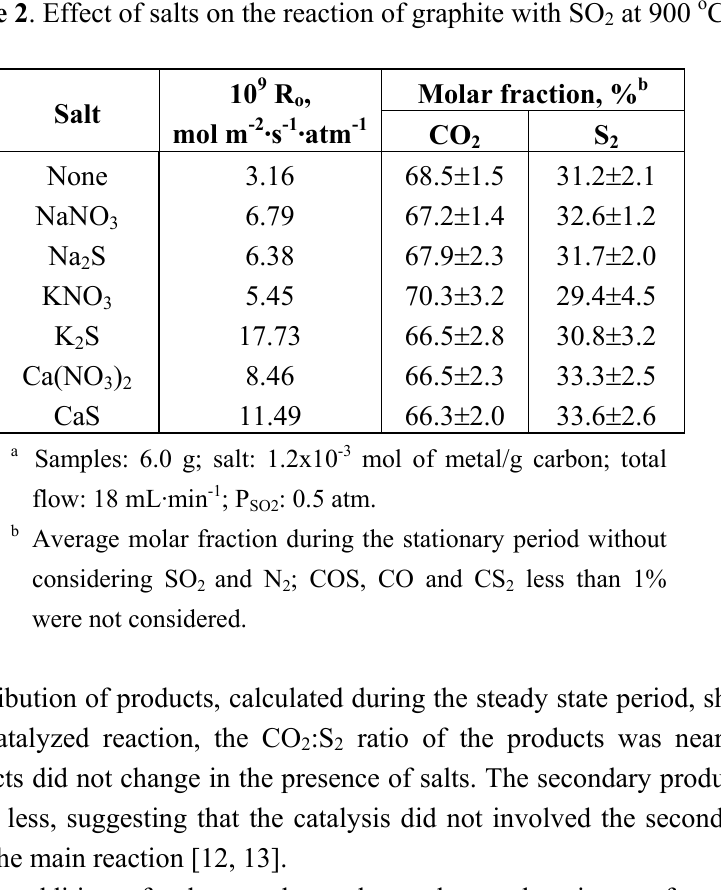
Table 2 . Effect of salts on the reaction of graphite with SO